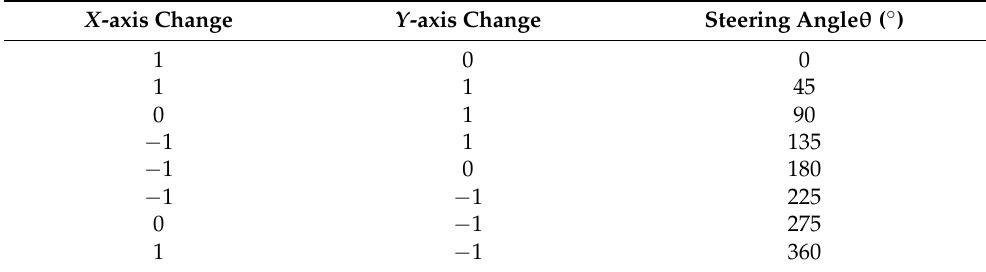
Table 1. Coordinate transformation and turn angle mapping